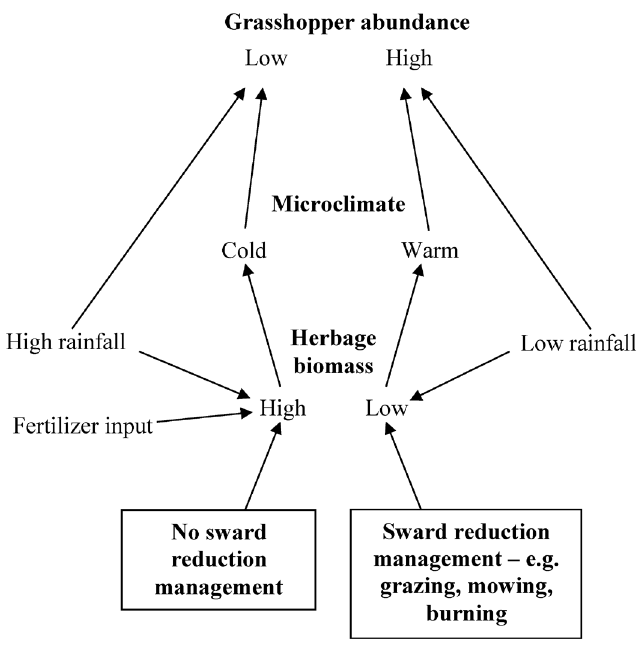
Fig. 5. A simplified conceptual model of the possible effects of man- agement to remove herbage biomass and lack of management on grasshopper abundance (the effects of fertilizer input and rainfall are added to provide a more holistic approach) (after Gardiner